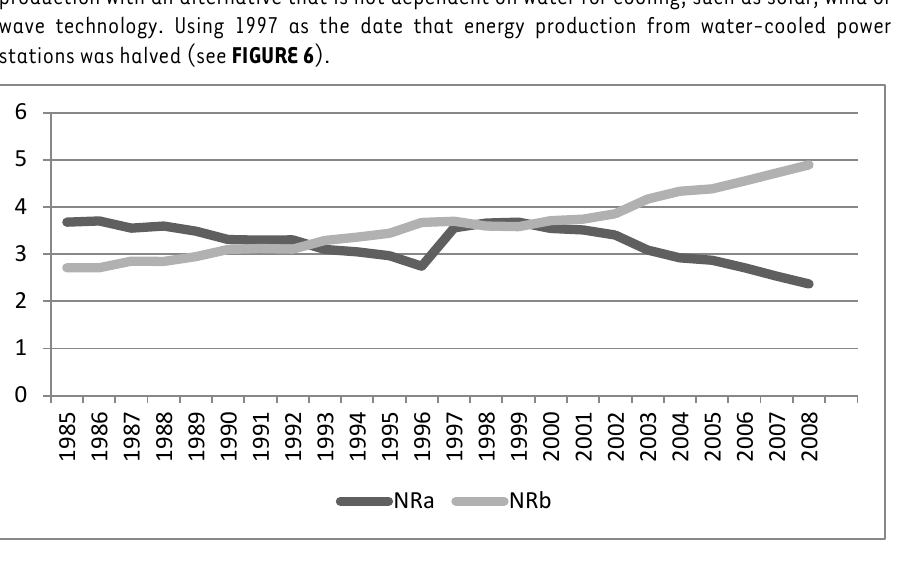
FIGURE 6: Plotting the resource conflict from 1985 to 2008, using 1985 as a base year and simulating an energy policy shift in 1997 Source: Author’s